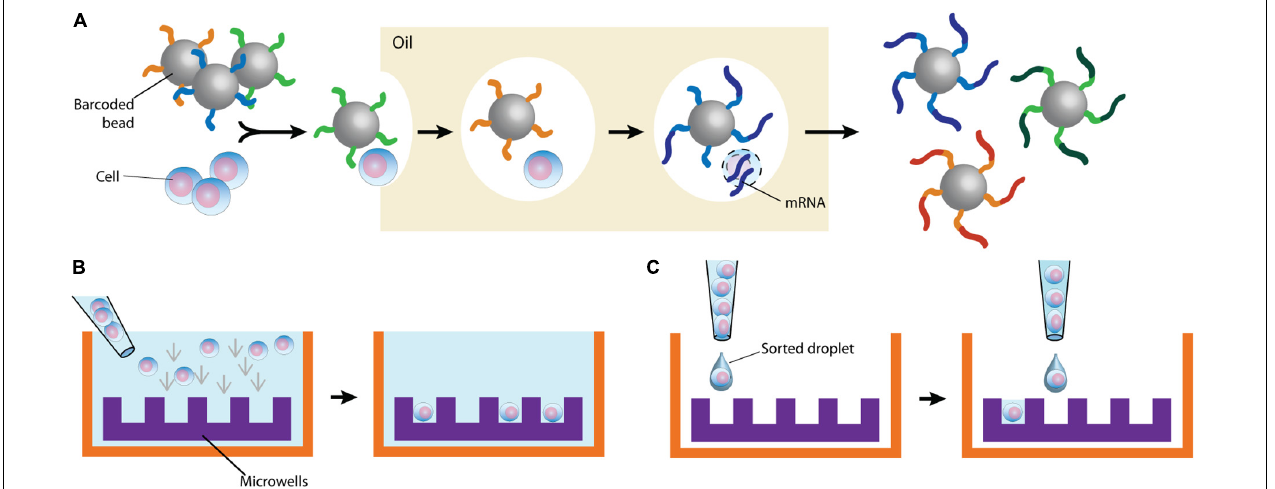
FIGURE 2 | Typical cell partitioning approaches. (A) Individual cells and barcoded beads are separated by droplet encapsulation in oil using microfluidic devices. Following intra-droplet cellular lysis, cellular mRNAs are captured by the beads for downstream application. (B) Cells are allowed to sediment in wells. To ensure single-cell resolution, sedimentation either occurs at a dilution minimizing doublets or using microwells calibrated to allow deposition of only one cell. (C) Single cells are directly sorted in wells. The staining of surface markers provides the mean to enrich for the desired subset of cells.